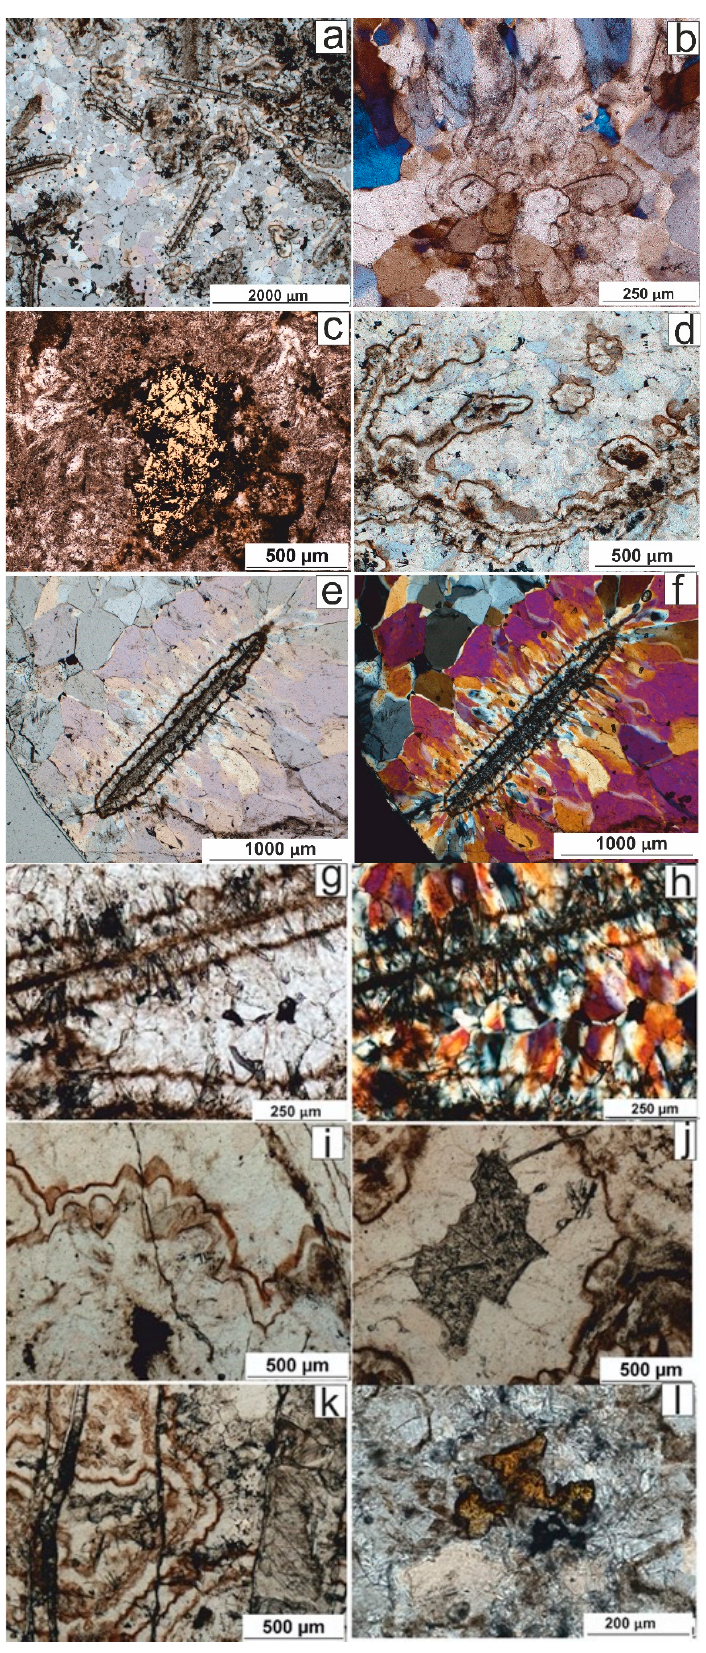
Figure 6. Textures of the synchysite-bearing quartz gangue of the vein. ( a ): Photomicrograph of the quartz gangue with numerous wormy clusters of hematite; plane polarizers. ( b ): Quartz rosette in